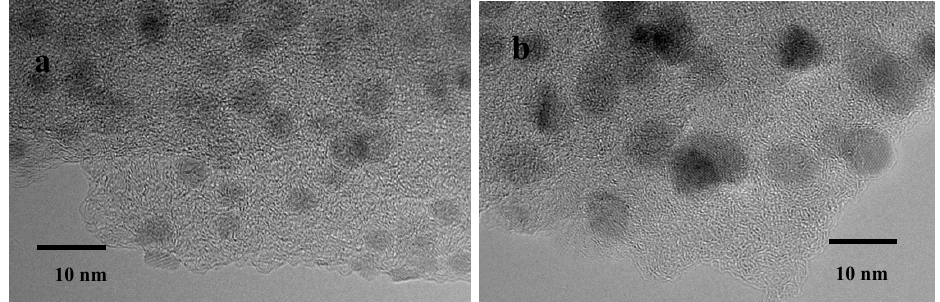
Figure 7. The TEM images of spent ( a ) Ni@C-700 and ( b )